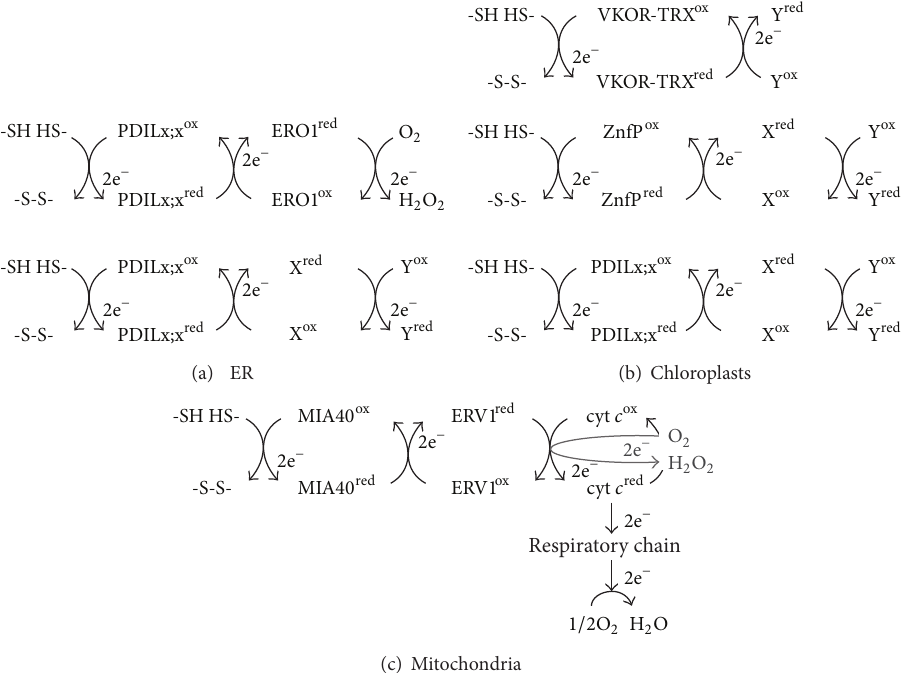
Figure 5: Multiple electron transfer pathways for oxidative protein folding in the ER, chloroplasts, and mitochondria of plant cells. (a) ERO1-dependent and PDI-dependent pathways in the ER. (b) VKOR-TRX-dependent, Zn finger protein-dependent, and PDI-dependent pathways in chloroplasts. LTO1 is indicated as VKOR-TRX. LQY1 and CYO1 are indicated as ZnfP. (c) ERV1-MIA40-meditaed pathway in mitochondria. One-electron carrier cytochrome c is indicated as cyt c . X ox and Y ox represent unidentified de novo disulfide-generating enzymes and electron acceptors, respectively. Whether de novo disulfide-generating enzymes (X ox ) are involved in the LQY1-dependent and CYO1-dependent disulfide transfer pathways is not